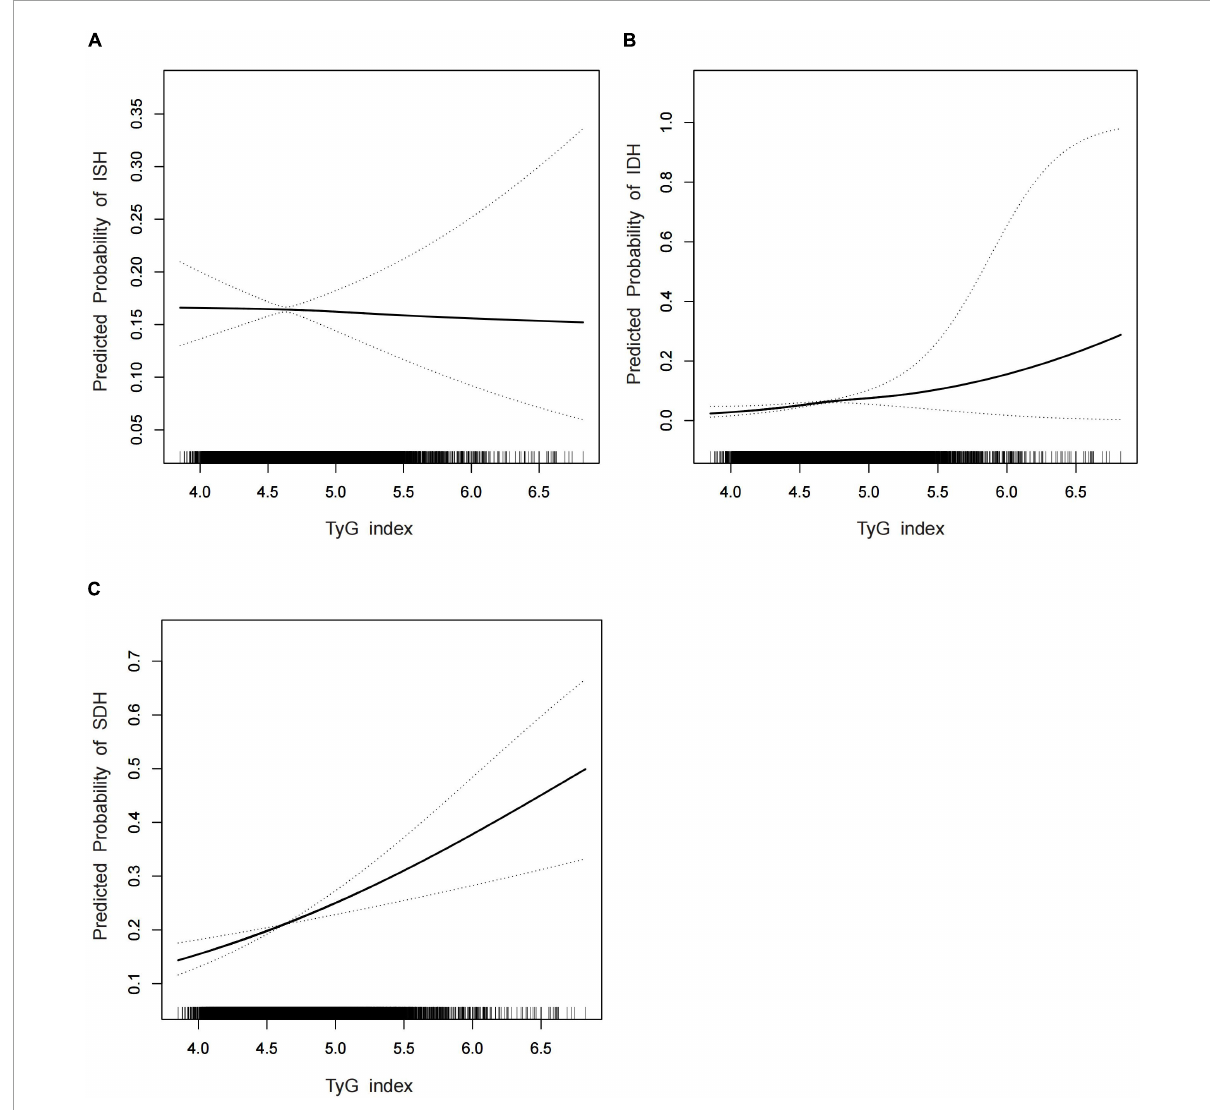
FIGURE1 (A–C) The fitted smooth demonstrated the trend between the predicted probabilities of ISH and TyG index (A) , the predicted probability of IDH and TyG index (B) , and the predicted probability of SDH and TyG index (C) . Adjusted factors included age, sex, pulse, TC, TG, FBG, HDL-C, LDL-C, BMI, abdominal obesity, smoking history, and binge drinking. The solid line and dashed line represent the estimated values and their corresponding 95% confidence